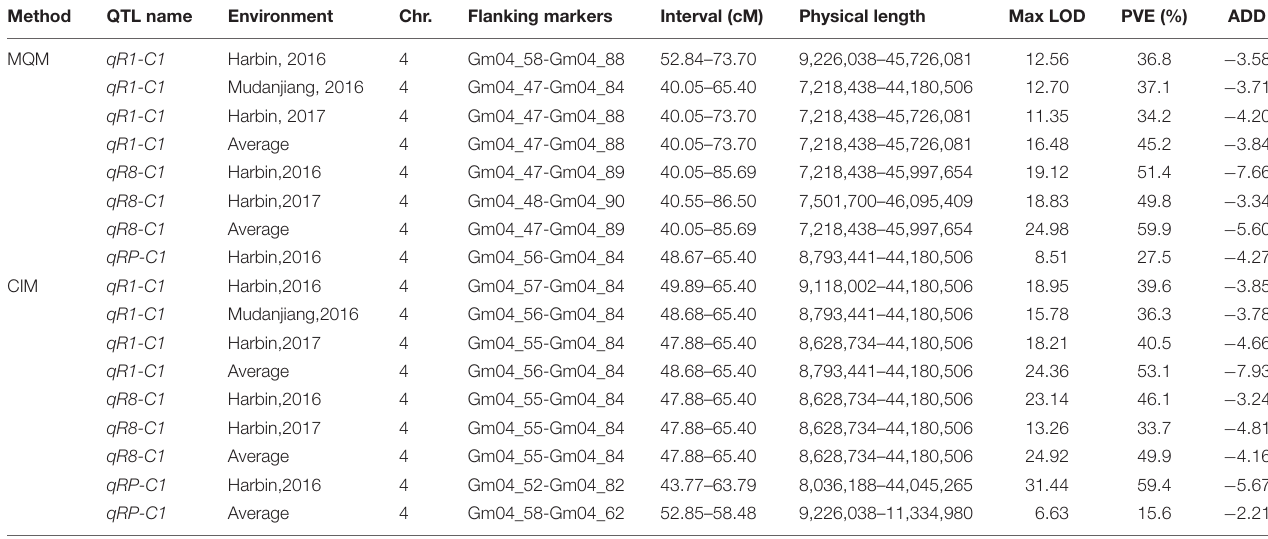
TABLE 5 | Detail information about the stable QTLs in DW